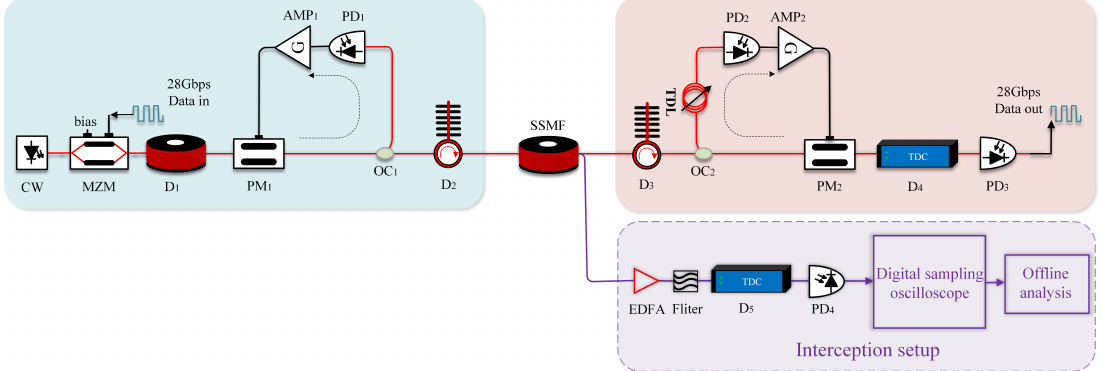
Figure 1. Experimental setup. CW, continuous-wave laser; MZM, Mach-Zehnder modulator; D, dispersion component; PM, phase modulator; OC, optical coupler; PD, photodetector; AMP, RF amplifier; TDL, tunable optical delay line; SSMF, standard single-mode fiber; EDFA, erbium-doped fiber amplifier; TDC, tunable dispersion compensator; and Filter, optical filter.